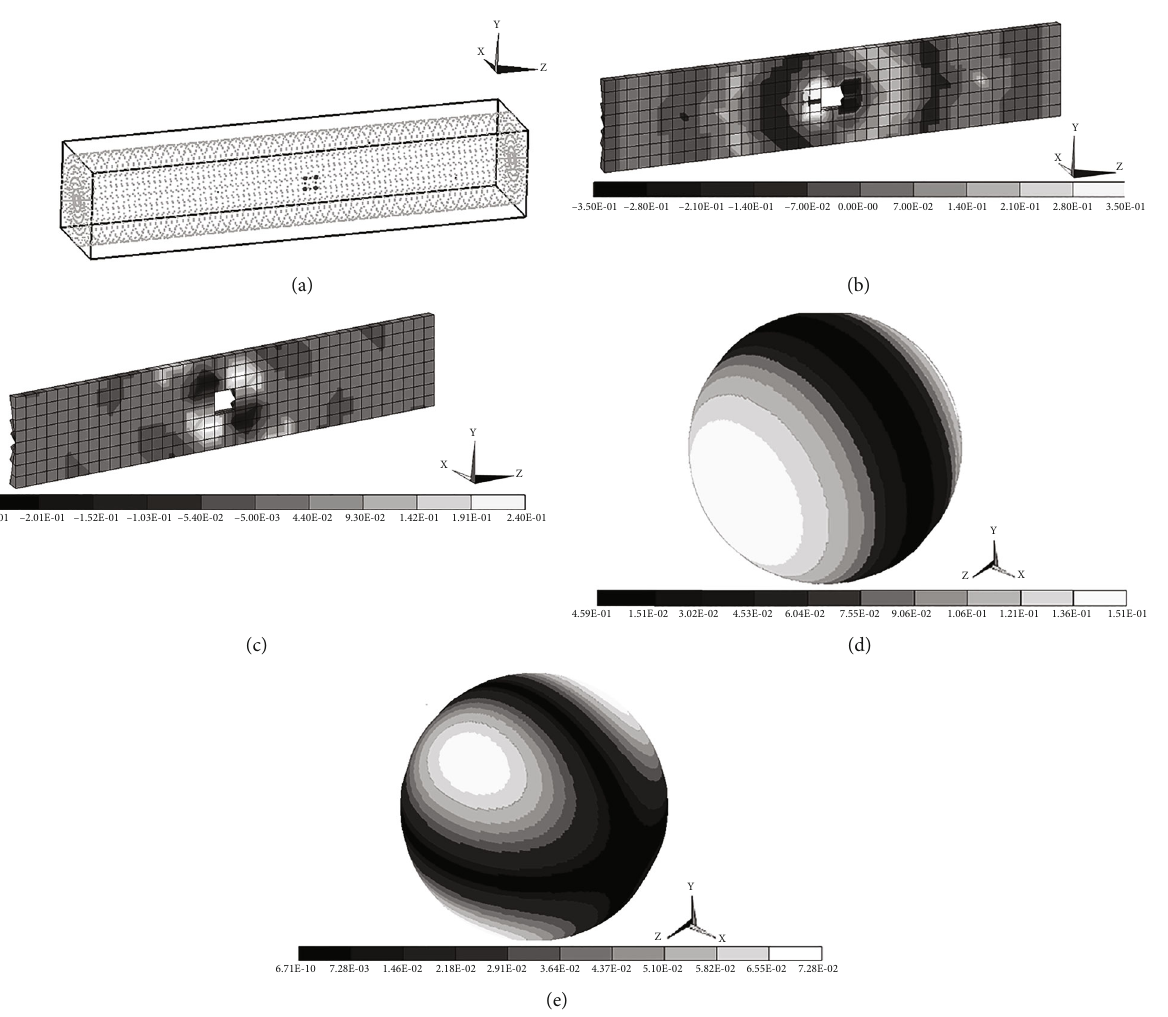
Figure 5: Example of a test calculation. The frequency is 1000Hz, the cylinder length is 8 m, and the diameter is 1.6m. (a) The calculation model geometry: the green points are the nodes of the outer boundary S , and the red and blue points are the nodes where the sources can be speci fi ed; (b) view of the pressure fi eld of a dipole source in the cross section, in the near fi eld: the real part is constructed, and the white rectangle covers the source area; (c) view of the pressure fi eld of a quadrupole source in the cross section, in the near fi eld; (d) radiation pattern of a dipole source, ∣ P ∣ ; and (e) radiation pattern of a quadrupole source, ∣ P ∣ . Table 1: Estimation of computation time for impedance matrix ½ Z (cid:2) , which de fi nes BC coe ffi cients in the